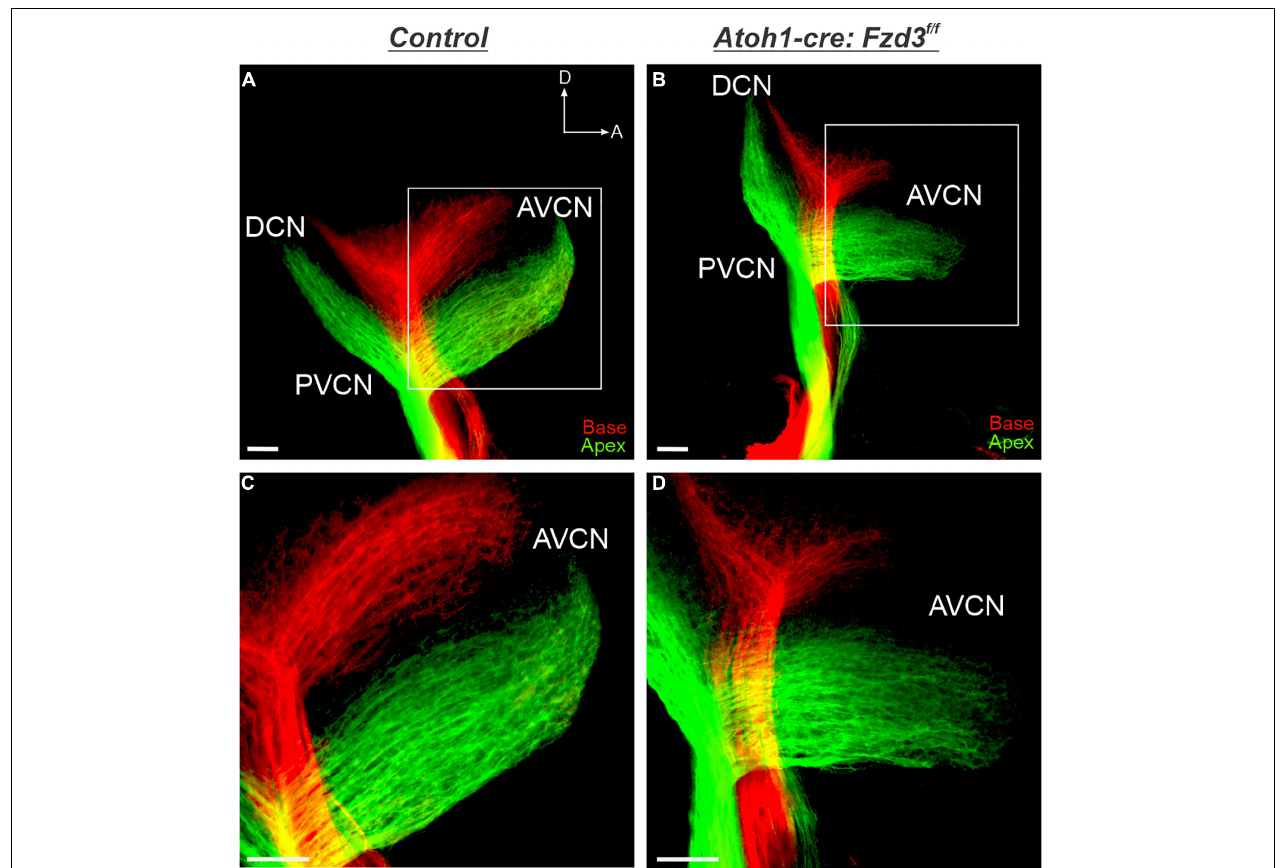
FIGURE 1 | Cochlear afferent central pathfinding unaffected by loss of Fzd3 within hair cells. Lipophilic dyes were applied to the base (red) and apex (green) of control (A,C) and Atoh1-cre:Fzd3 f / f mutant (B,D) cochleae at P0 and their central projections were analyzed (A–D) . In the control, afferent neurites from the base and apex remain segregated and bifurcate sending projections toward the DCN and AVCN (A,C) . In the Atoh1-cre:Fzd3 f / f mutant, afferent neurites from the base and apex also remain segregated and bifurcate sending projections toward the DCN and AVCN (B,D) . Higher magnification of the AVCN (C,D) showing the segregation of basal and apical afferents in both control (C) and Atoh1-cre:Fzd3 f / f mutant (D) central projections. CN, cochlear nucleus; AVCN, anteroventral cochlear nucleus; DCN, dorsal cochlear nucleus; PVCN, posteroventral cochlear nucleus; A, anterior; D, dorsal. Orientation for all panels the same as (A) . Scale bars, 100 µ m. Three mutant animals and three littermate controls were